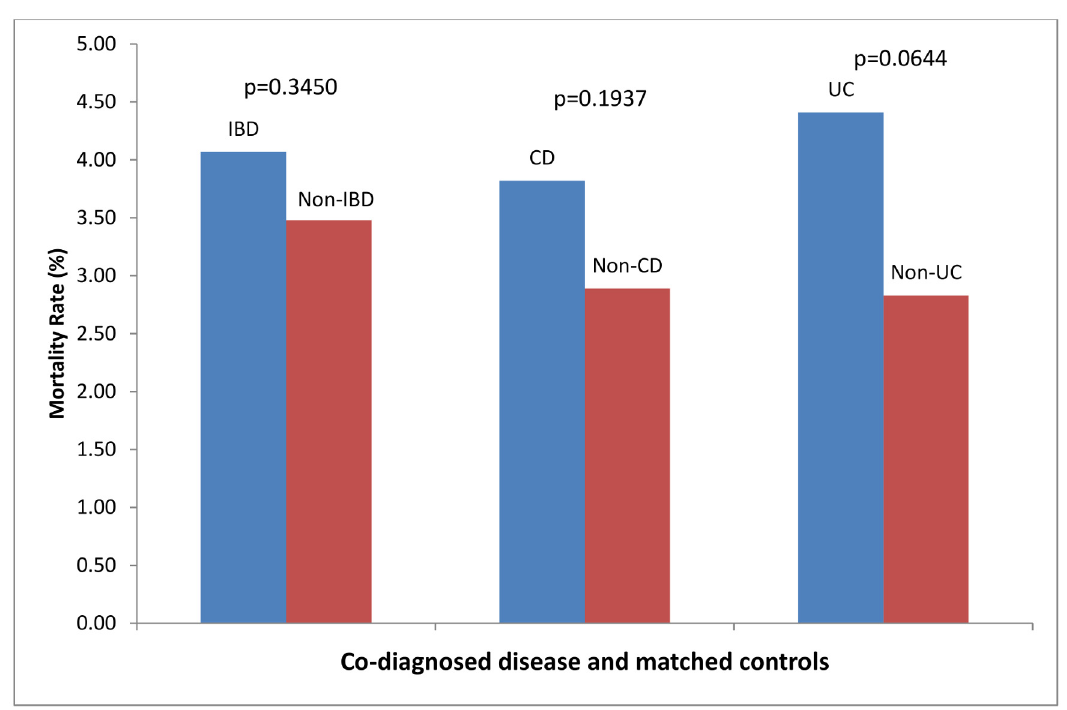
Fig 2. Hospital Mortality Rates for Co-Diagnosis and Matched Controls for Patients Hospitalized with Primary Diagnosis of Congestive Heart Failure